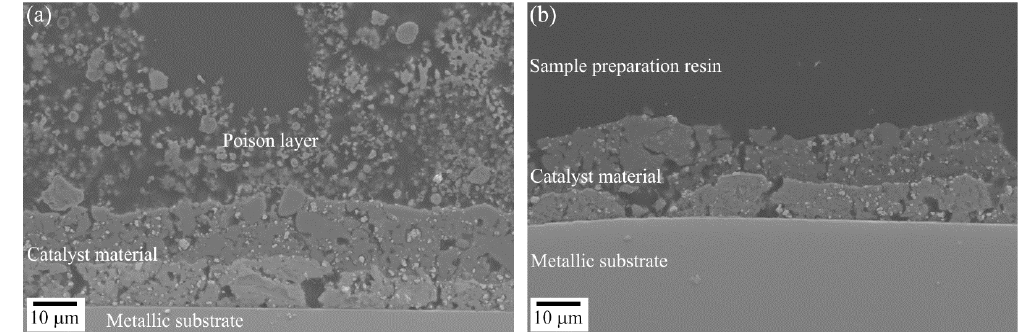
Figure 12. The cross-sectional SEM images of the natural gas catalyst, ( a ) the inlet part of the vehicle-aged catalyst and ( b ) the outlet part of the vehicle-aged